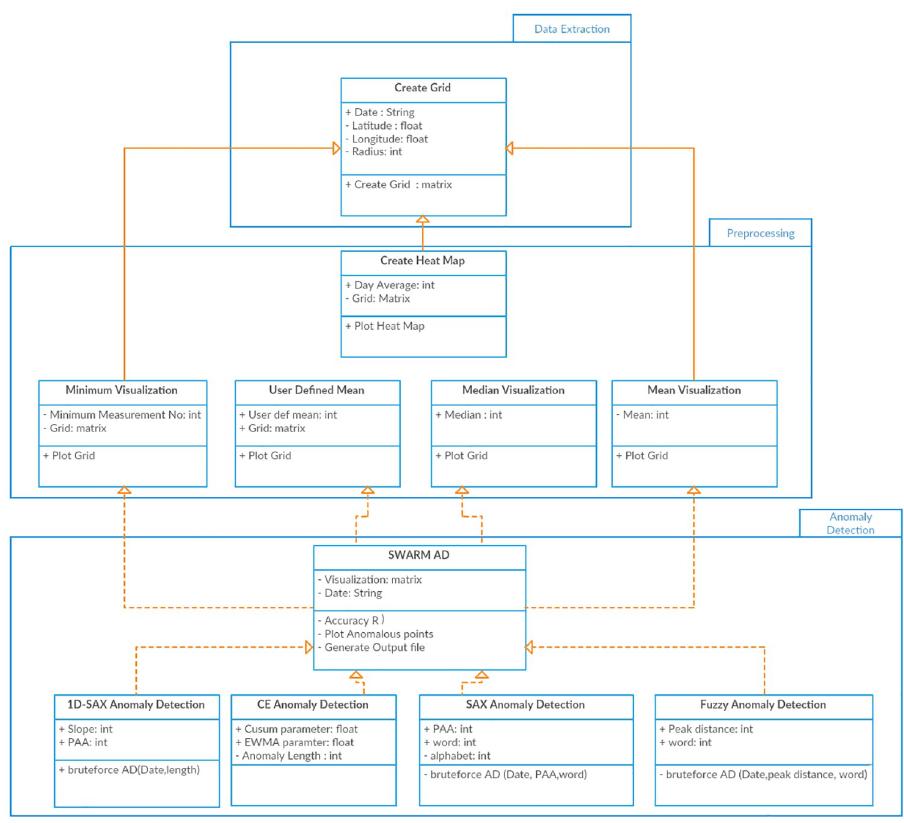
Fig 3. Class diagram of the proposed